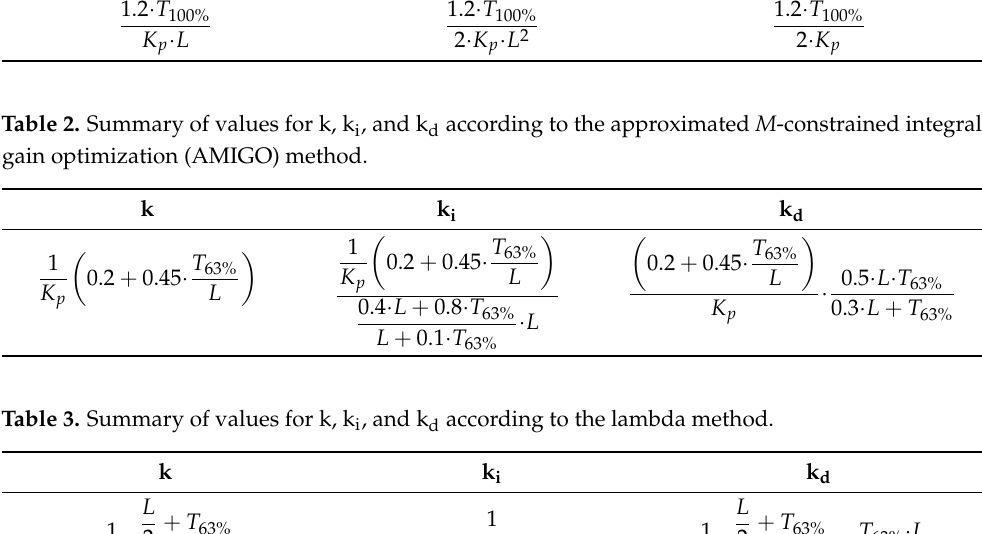
Table 1. Summary of values for k, k i , and k d according to the Ziegler–Nichols method. K k i k d